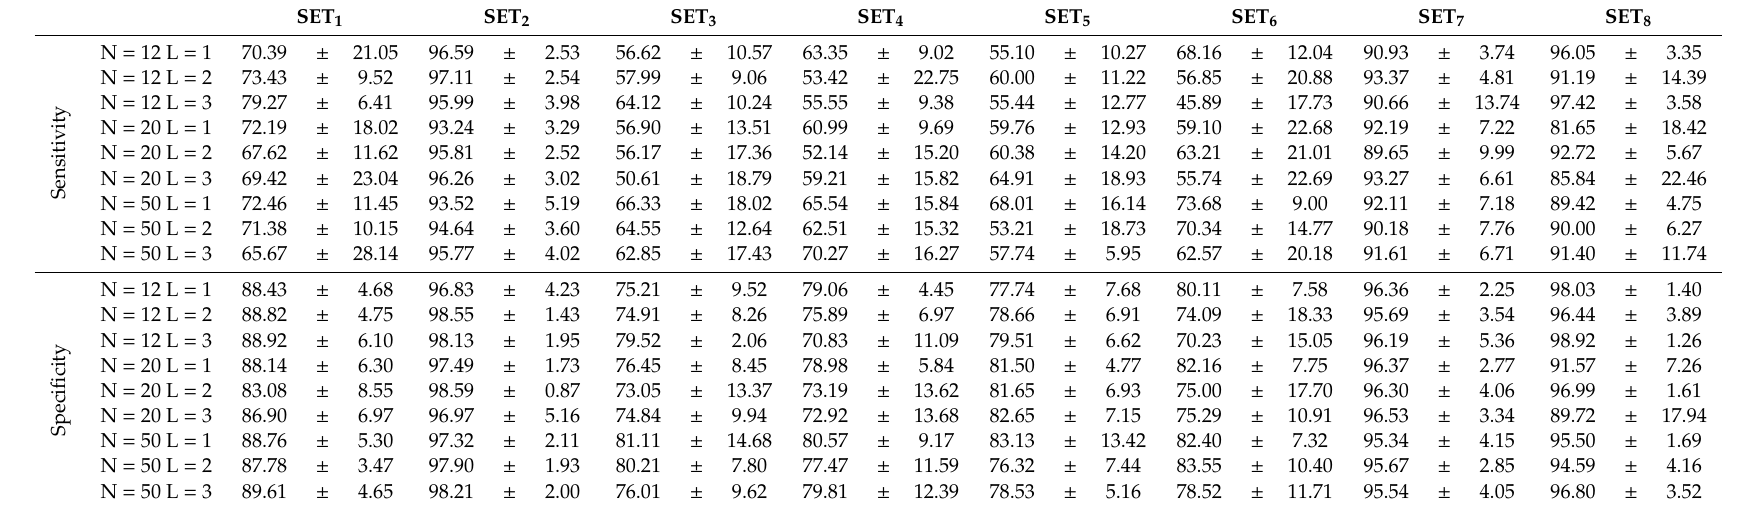
Table 2. Sensitivity and specificity of artificial neural networks (ANNs) considering di ff erent features (SET i , i = 1, ... , 8) and nine di ff erent architectures (see Section 2.7 for details) of ANNs were